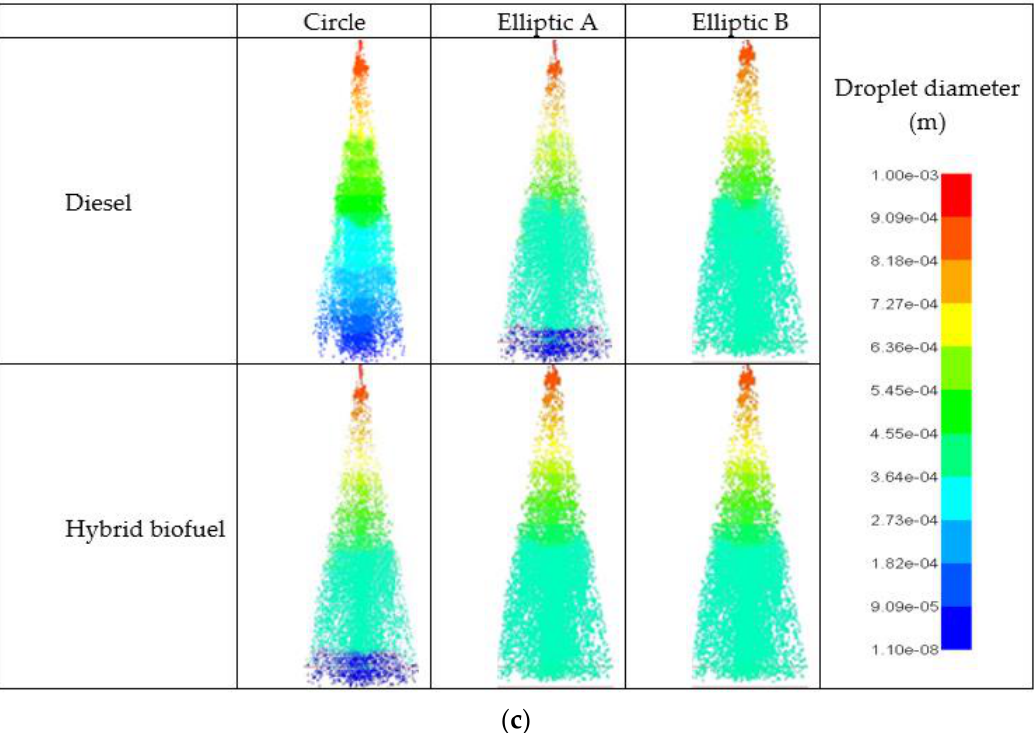
Figure 14. Fuel spray images at 0.9 ms ASOI for elliptical and circular nozzle types: ( a ) 50 MPa pressure injection, ( b ) 100 MPa pressure injection, and ( c ) 180 MPa pressure injection.